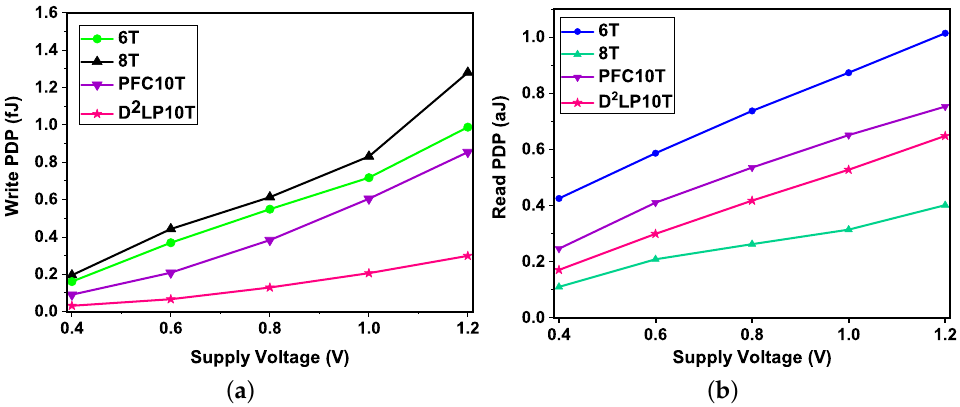
Figure 13. Effect of supply voltage variations on ( a ) write PDP and ( b ) read PDP.